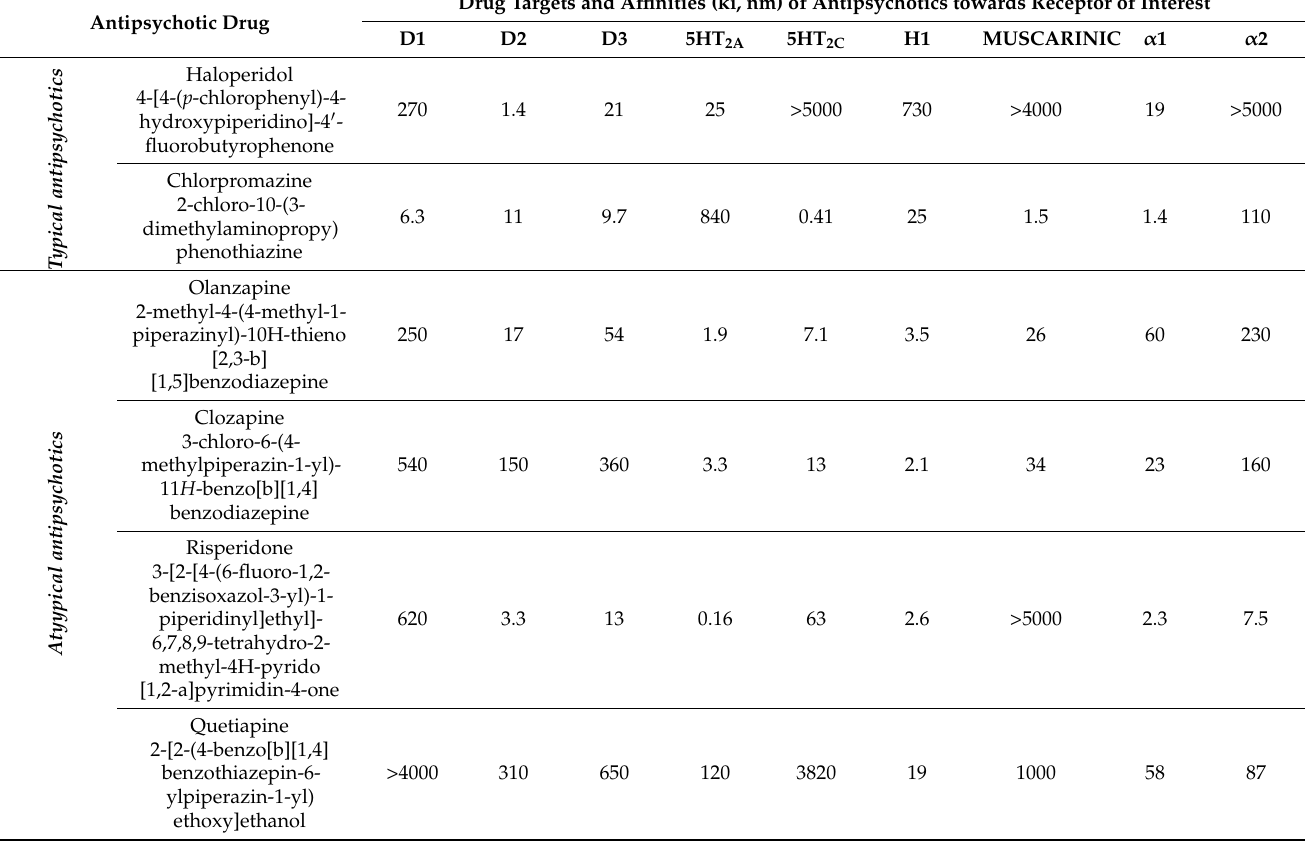
Table 1. Multitargeting of clinically available antipsychotic (neuroleptic) drugs. Here, multitargeting refers to interaction with various and different receptor targets (function of the molecule) not related specifically to the molecule structure